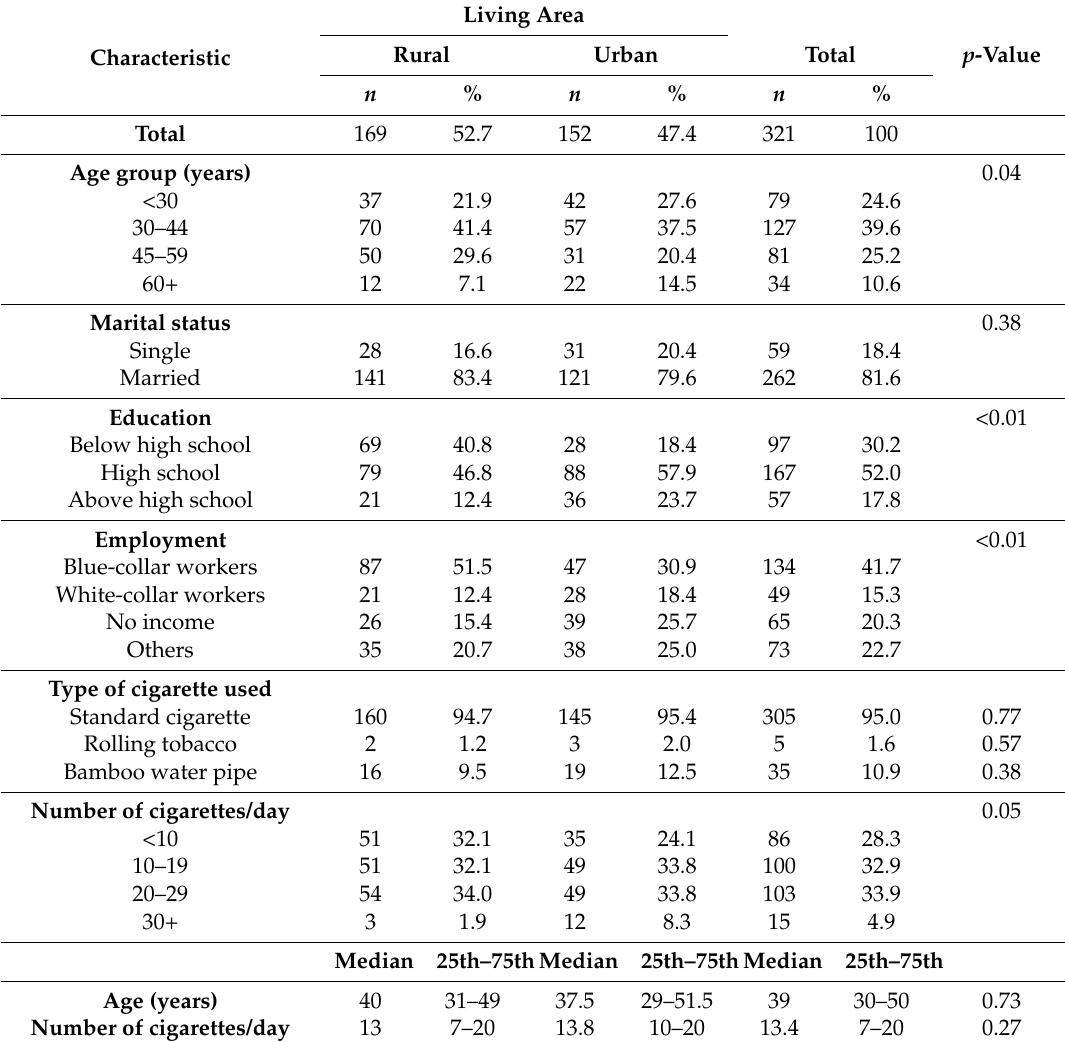
Table 1. Socio-economic characteristic of the